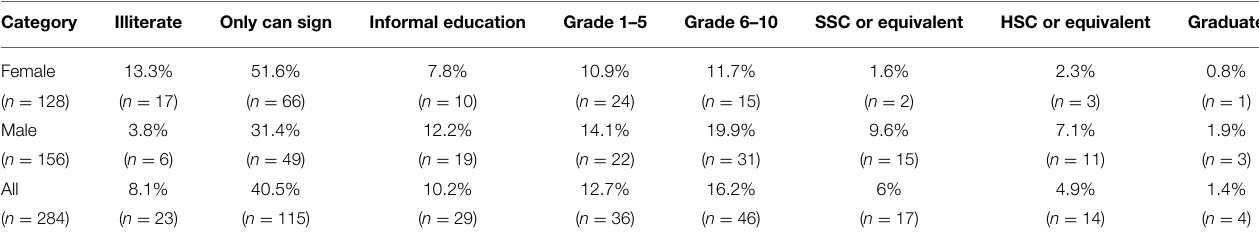
TABLE 5 | Educational status of the